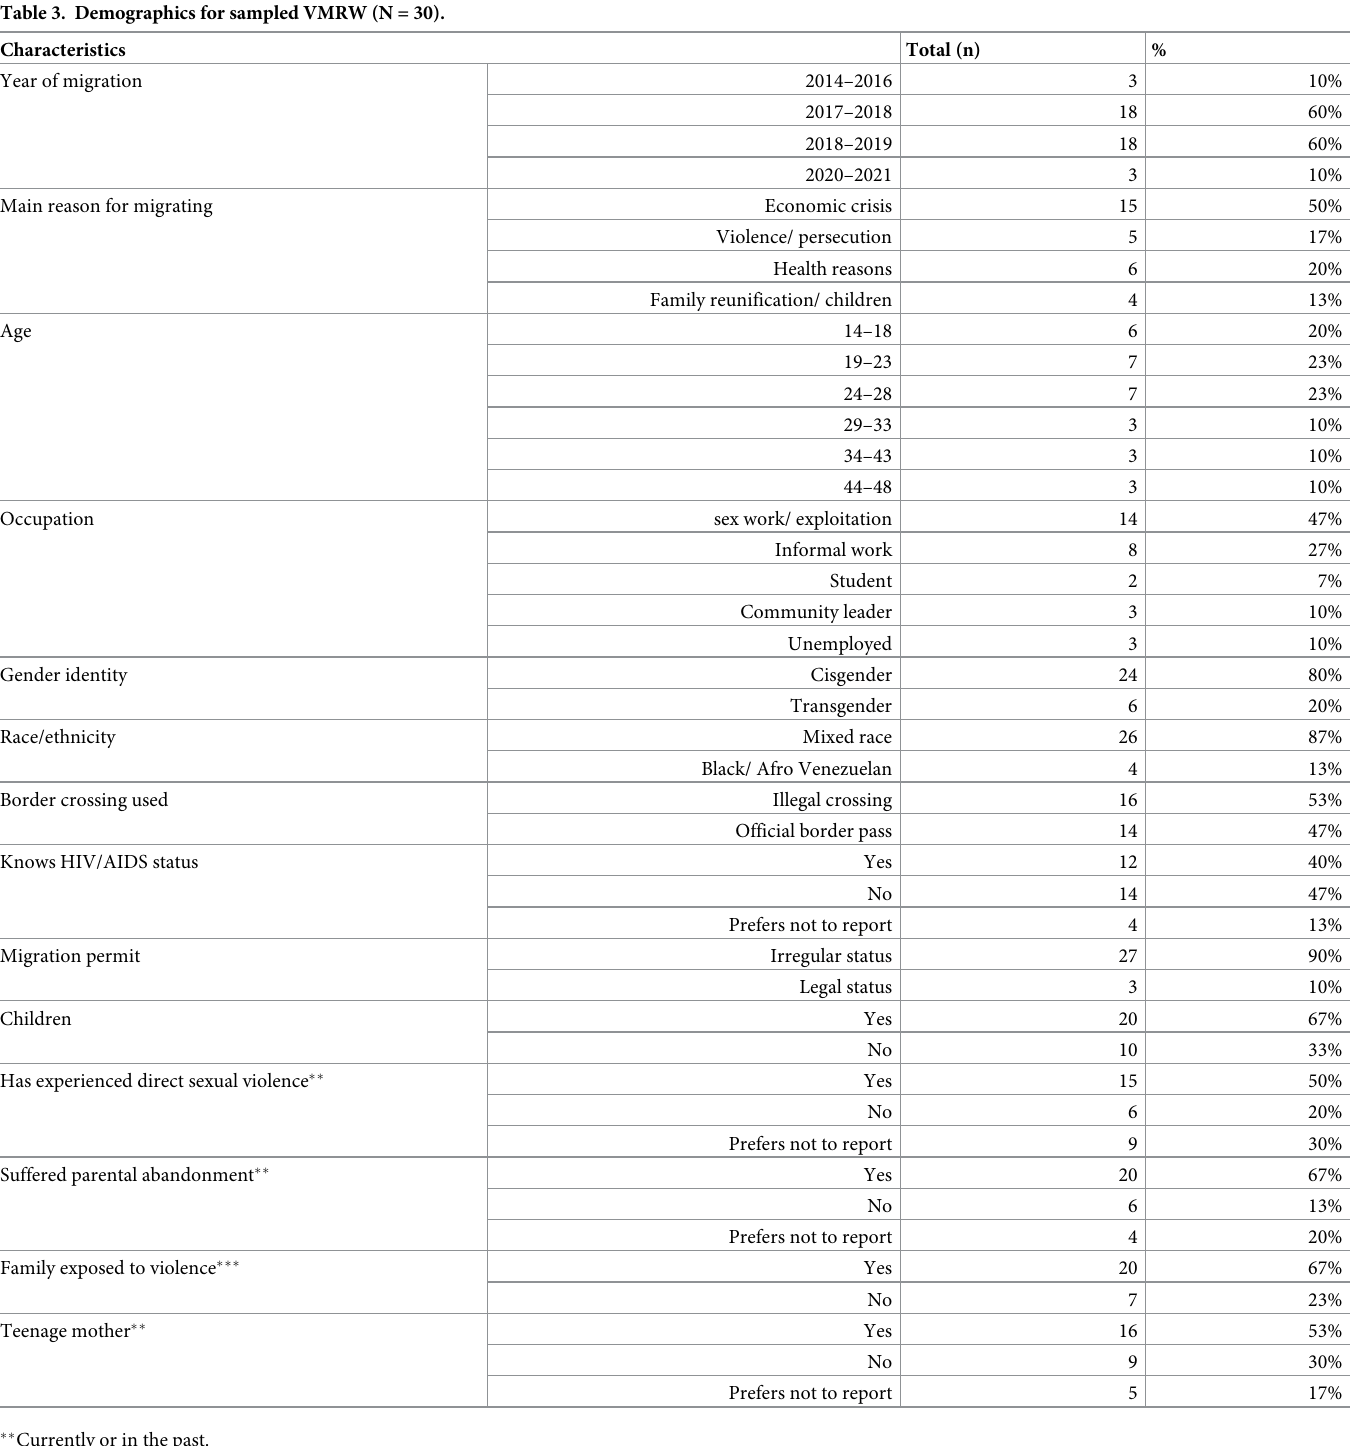
Table 3. Demographics for sampled VMRW (N = 30).